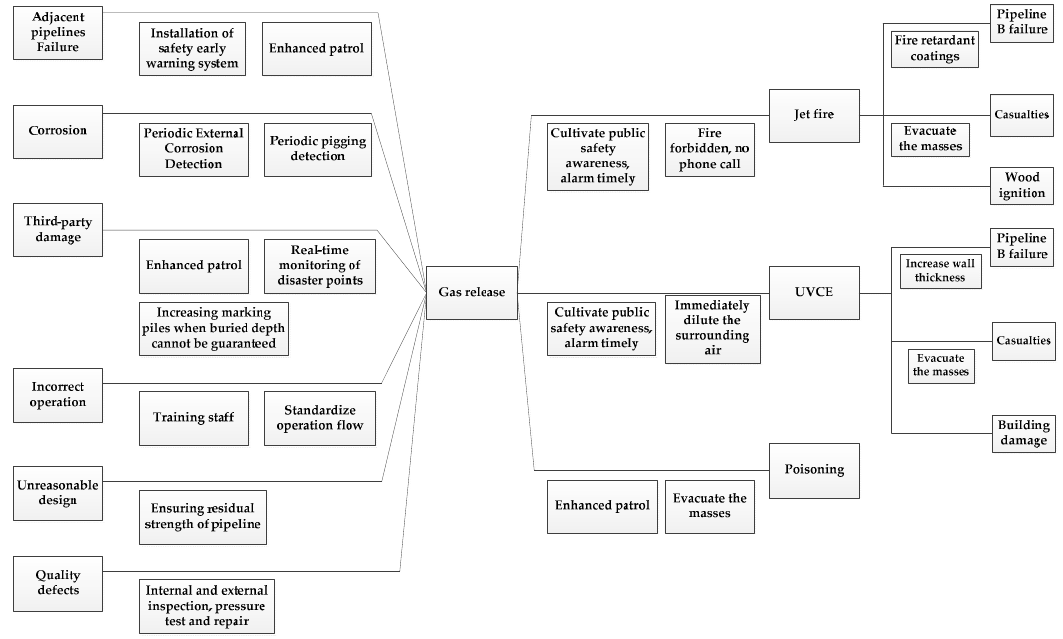
Figure 13. Bow-tie diagram of natural gas pipeline leakage for the PLOD system. 460